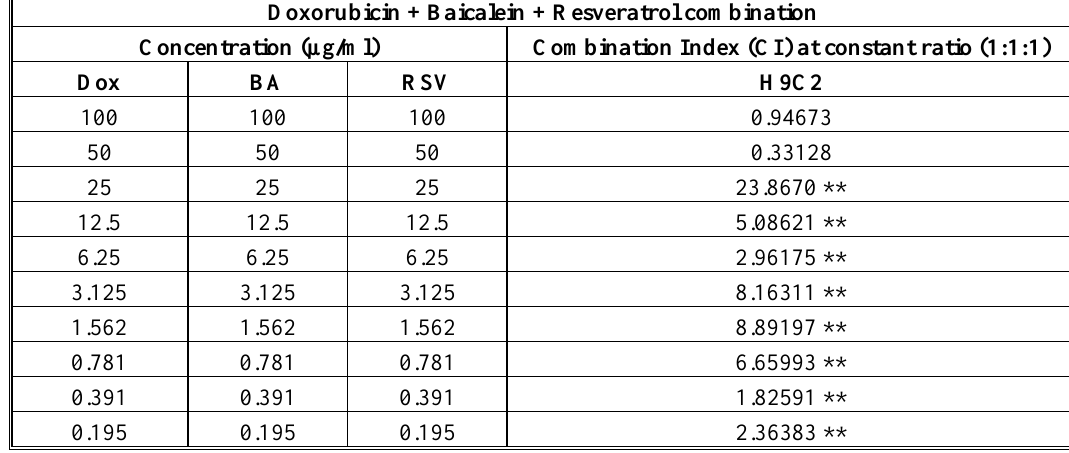
Table 4. Combination index (CI) for the combination of doxorubicin (Dox), baicalein (BA) and resveratrol (RSV) using a constant ratio (1:1:1) on H9C2